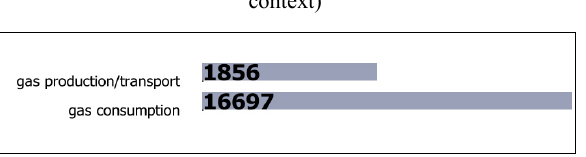
Figure 6. Amount of non-renewable primary energy associated with the natural gas supply chain nodes for housing heating, MJ / person * year (Magentino-Abbiatense context) The IGs in the Figures (5-9) illustrate the different amount of primary energy associated with the activities of the supply chain through circles of different diameters. The different color refers to the type of energy (non-renewable magenta and renewable green). In particular, each node includes the amount of energy used for the production of materials involved and the direct energy use.